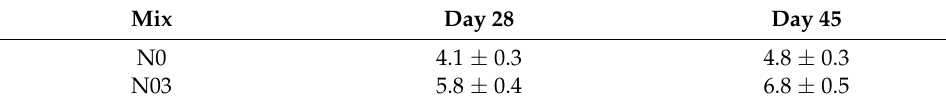
Table 4. Compression strength (f c ) of samples with 0% FC (N0) and 0.3% FC (N03).